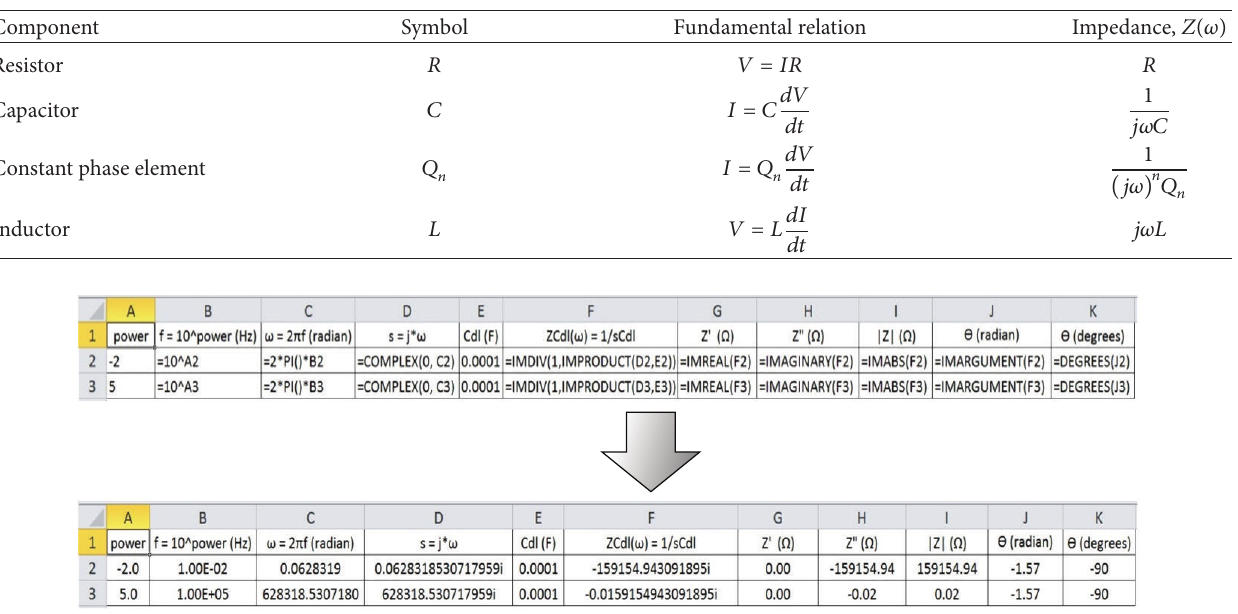
Table 1: Basic electrical elements and their current-voltage relation.